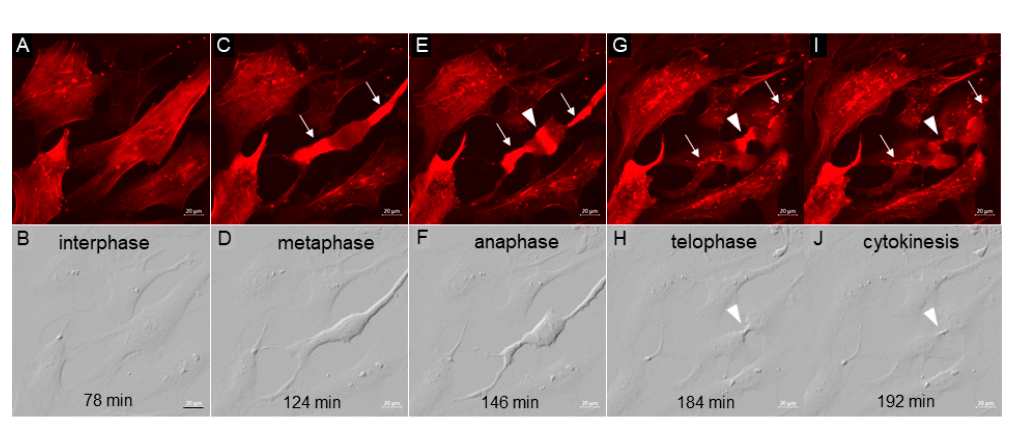
Figure 3. Still images taken from the movie shown in Supplemental Figure S1. The images are from SiR-actin-stained normal TM cells ( A , C , E , G , I ) or phase gradient contrast ( B , D , F , H , J ). Arrows in ( C , E , G , I ) point to areas of actin staining that appear to be anchor points. Arrowhead in ( E , G , I ) point to the actin contractile ring, which can also be seen in the phase images ( H , J ), where the membrane is invaginated and pinched off to produce two daughter cells. The stages of mitosis (interphase, metaphase, anaphase, telophase, and cytokinesis) and time in minutes are indicated. Scale bar = 20 µm.